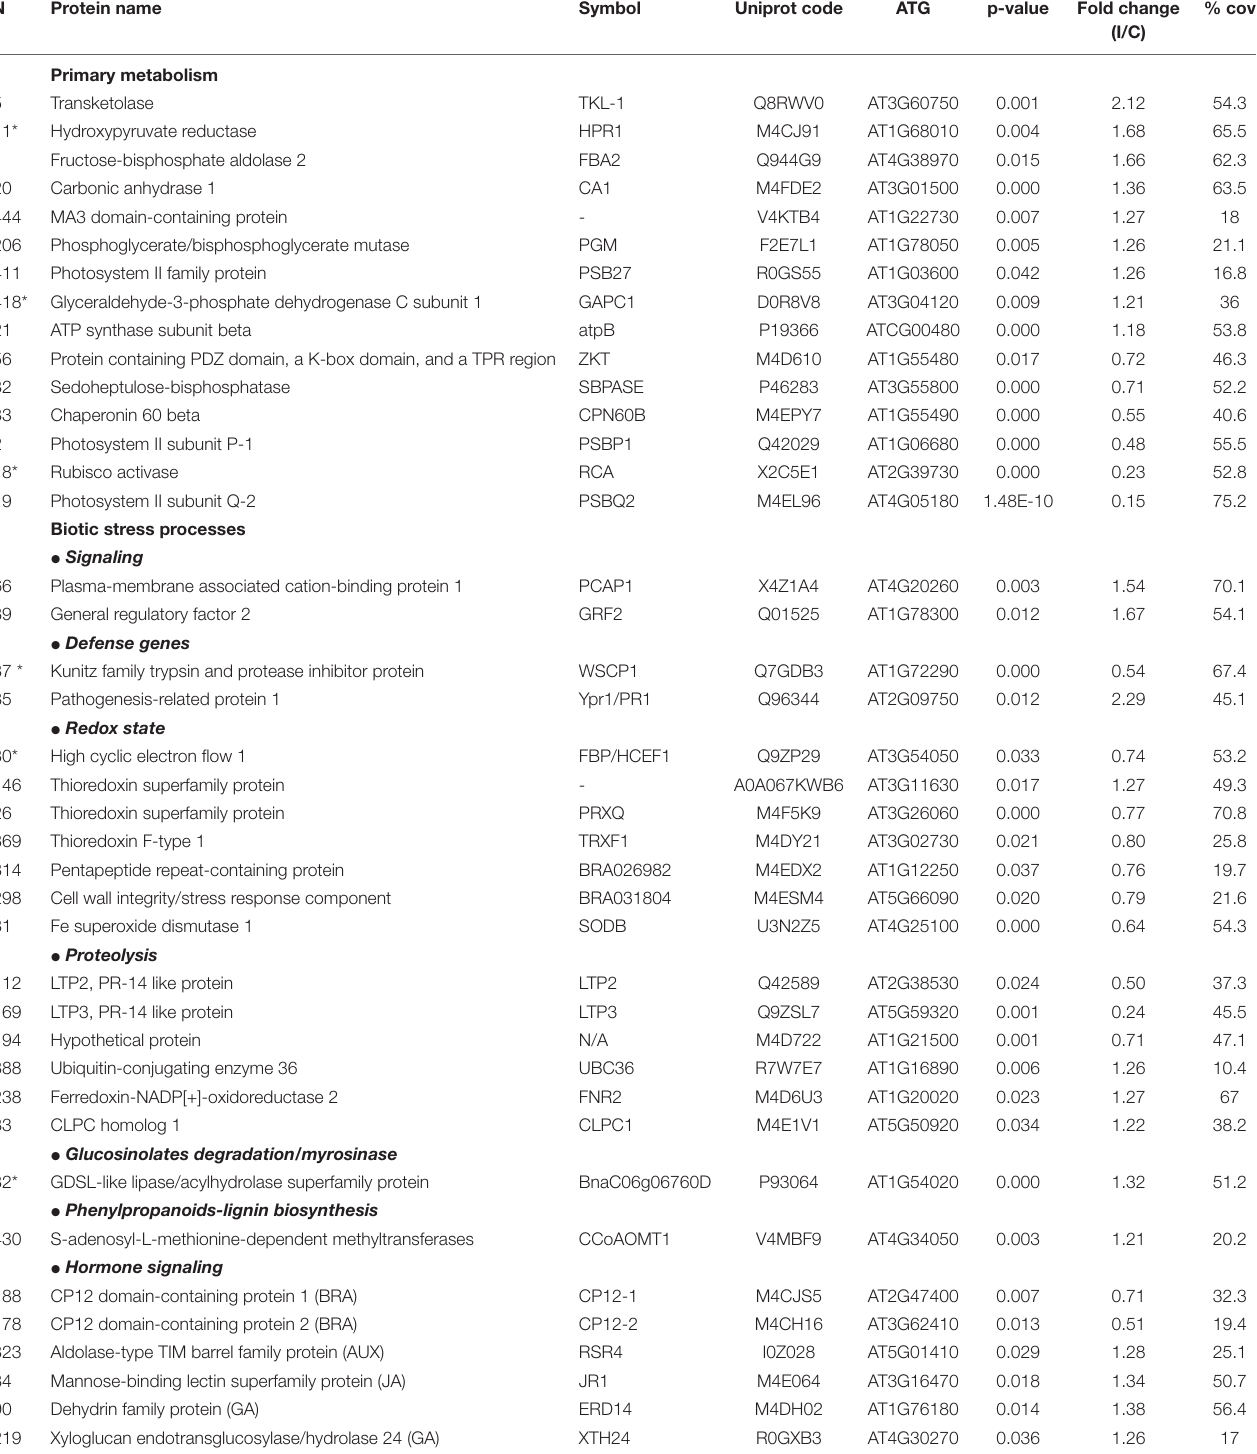
TABLE 2 | Proteins differentially induced 12 dpi. FC(I/C): the protein abundance ratio (inoculated/control);% coverage: percentage of matching amino acids from identified peptides divided by the total number of amino acids in the